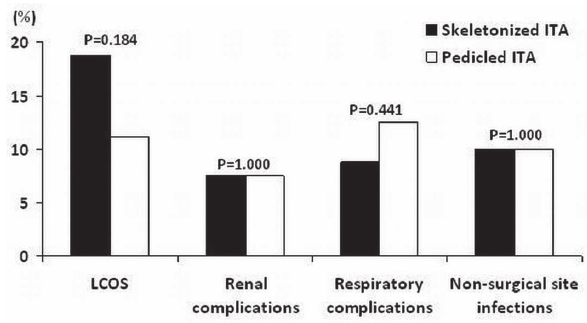
Fig. 4 – Description of postoperative complications in elderly undergoing CABG. ITA = internal thoracic artery; CABG = coronary artery bypass graft; LCOS = low cardiac